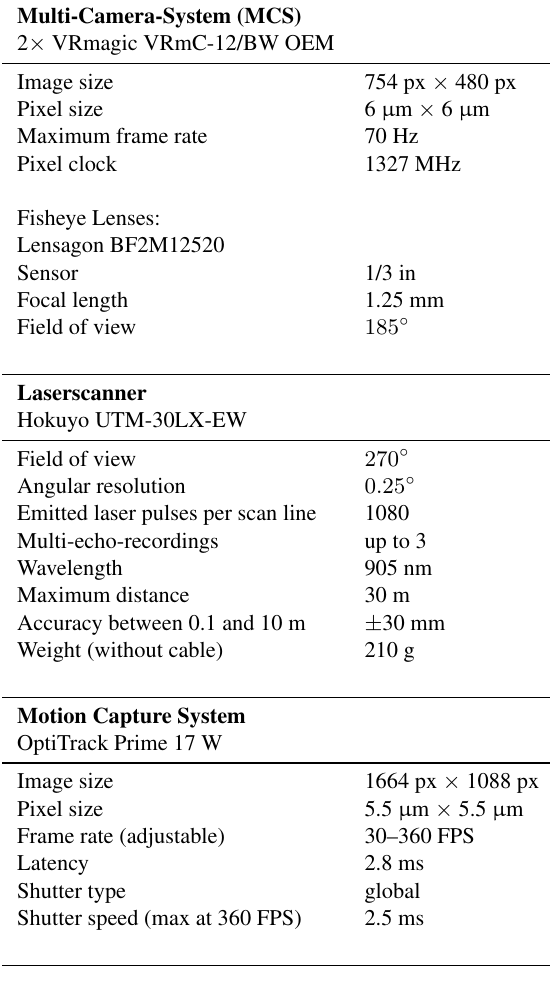
Table 1: Specifications of all sensors used in the experiments.